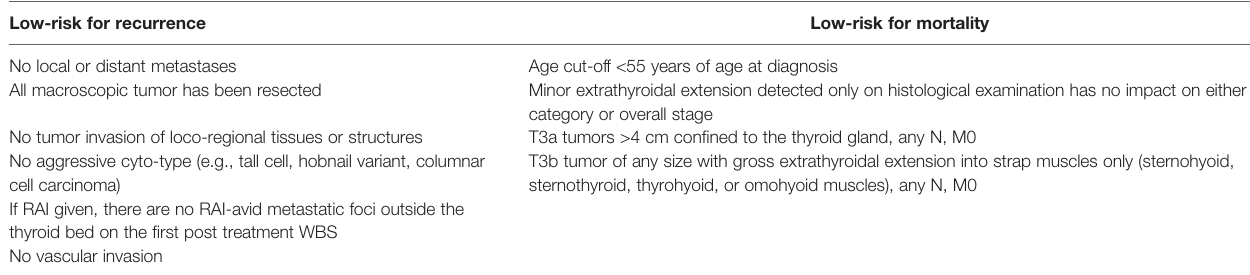
TABLE 5 | Low risk de fi nition for recurrence and mortality of well differentiated thyroid